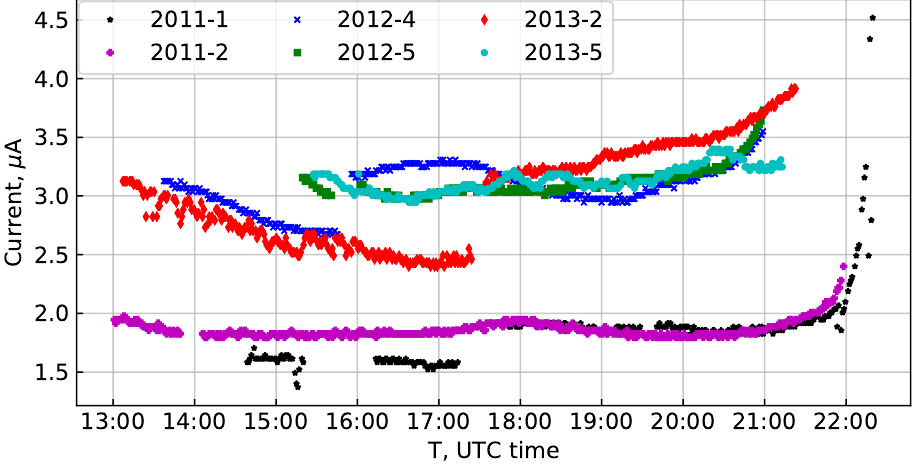
Figure 10. The central PMT currents in different